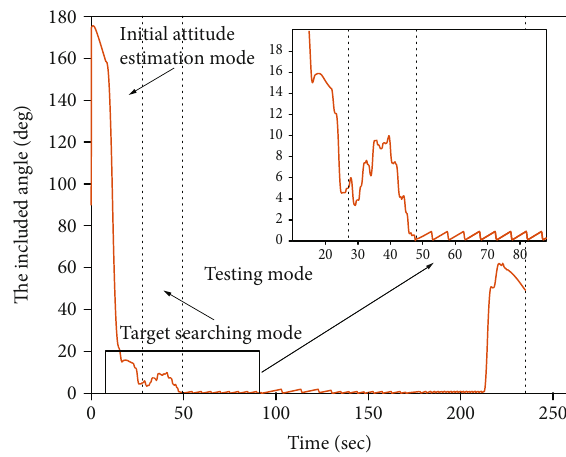
Figure 9: Time history of the included angle between the satelliteâ € ™ s x axis and the array pointing from the satellite to the target during all modes.